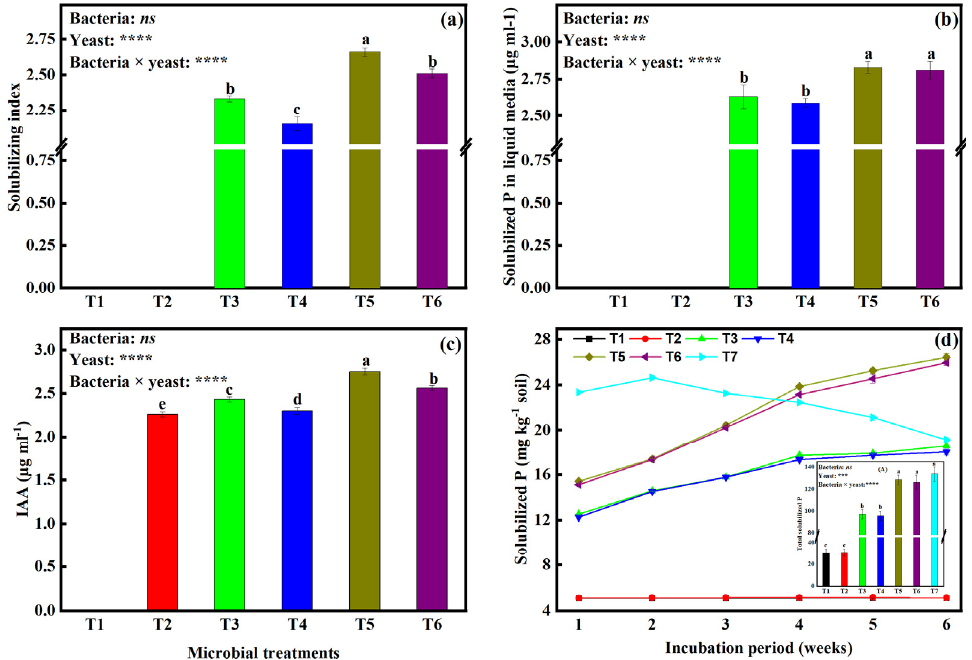
Figure 1. In vitro measurements of ( a ) P solubilization index, ( b ) solubilized P in liquid media, ( c ) IAA production, and ( d ) solubilized P in soil under different microbial treatments. Data (means ± SE, n = 5). p -values of two-way ANOVAs followed by different letters denote significant differences between treatments at p < 0.05 according to Tukey’s HSD. p -values of two-way ANOVAs of bacteria, yeast, and their interaction (bacteria × yeast) are indicated: p < 0.05, *; p < 0.01, **; p < 0.001, ***; p